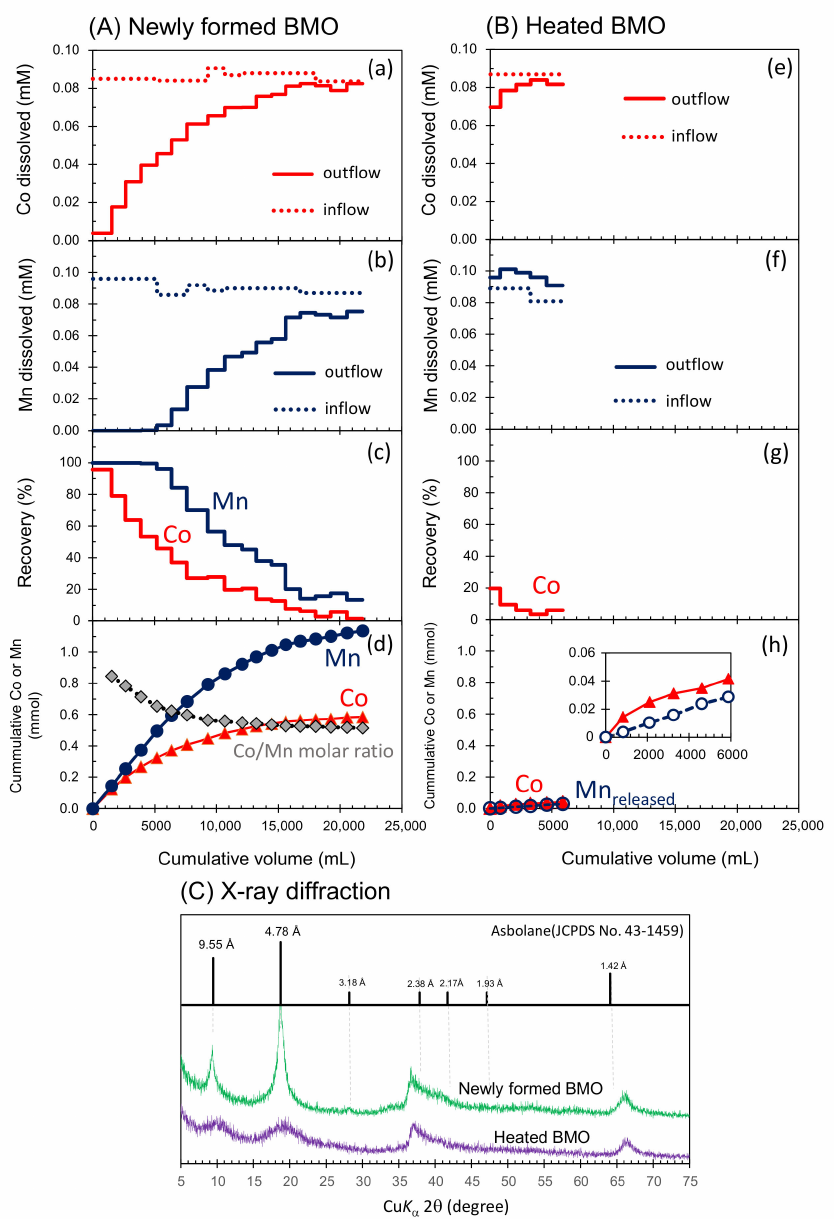
Figure 8. Column experiments using ( A ) newly formed and ( B ) heated biogenic manganese oxides (BMOs; 0.40 mmol) loaded by Mn 2+ /Co 2+ binary solutions at pH 7.0 (10 mM HEPES buffer) with flow rates of 50–55 mL h − 1 . Concentrations of dissolved Co 2+ ( a , e ) and Mn 2+ ( a , f ) in inflows and outflows, and removal efficiencies of Co 2+ and Mn 2+ ( c , g ). Cumulative amounts of Co ( d , h ), and those of sequestered ( d ) or released ( h ) Mn were plotted as elution volumes. ( C ) X-ray diffraction of BMOs unpacked after column experiments with XRD patterns of asbolane (from the JCPDS No. 43-1459